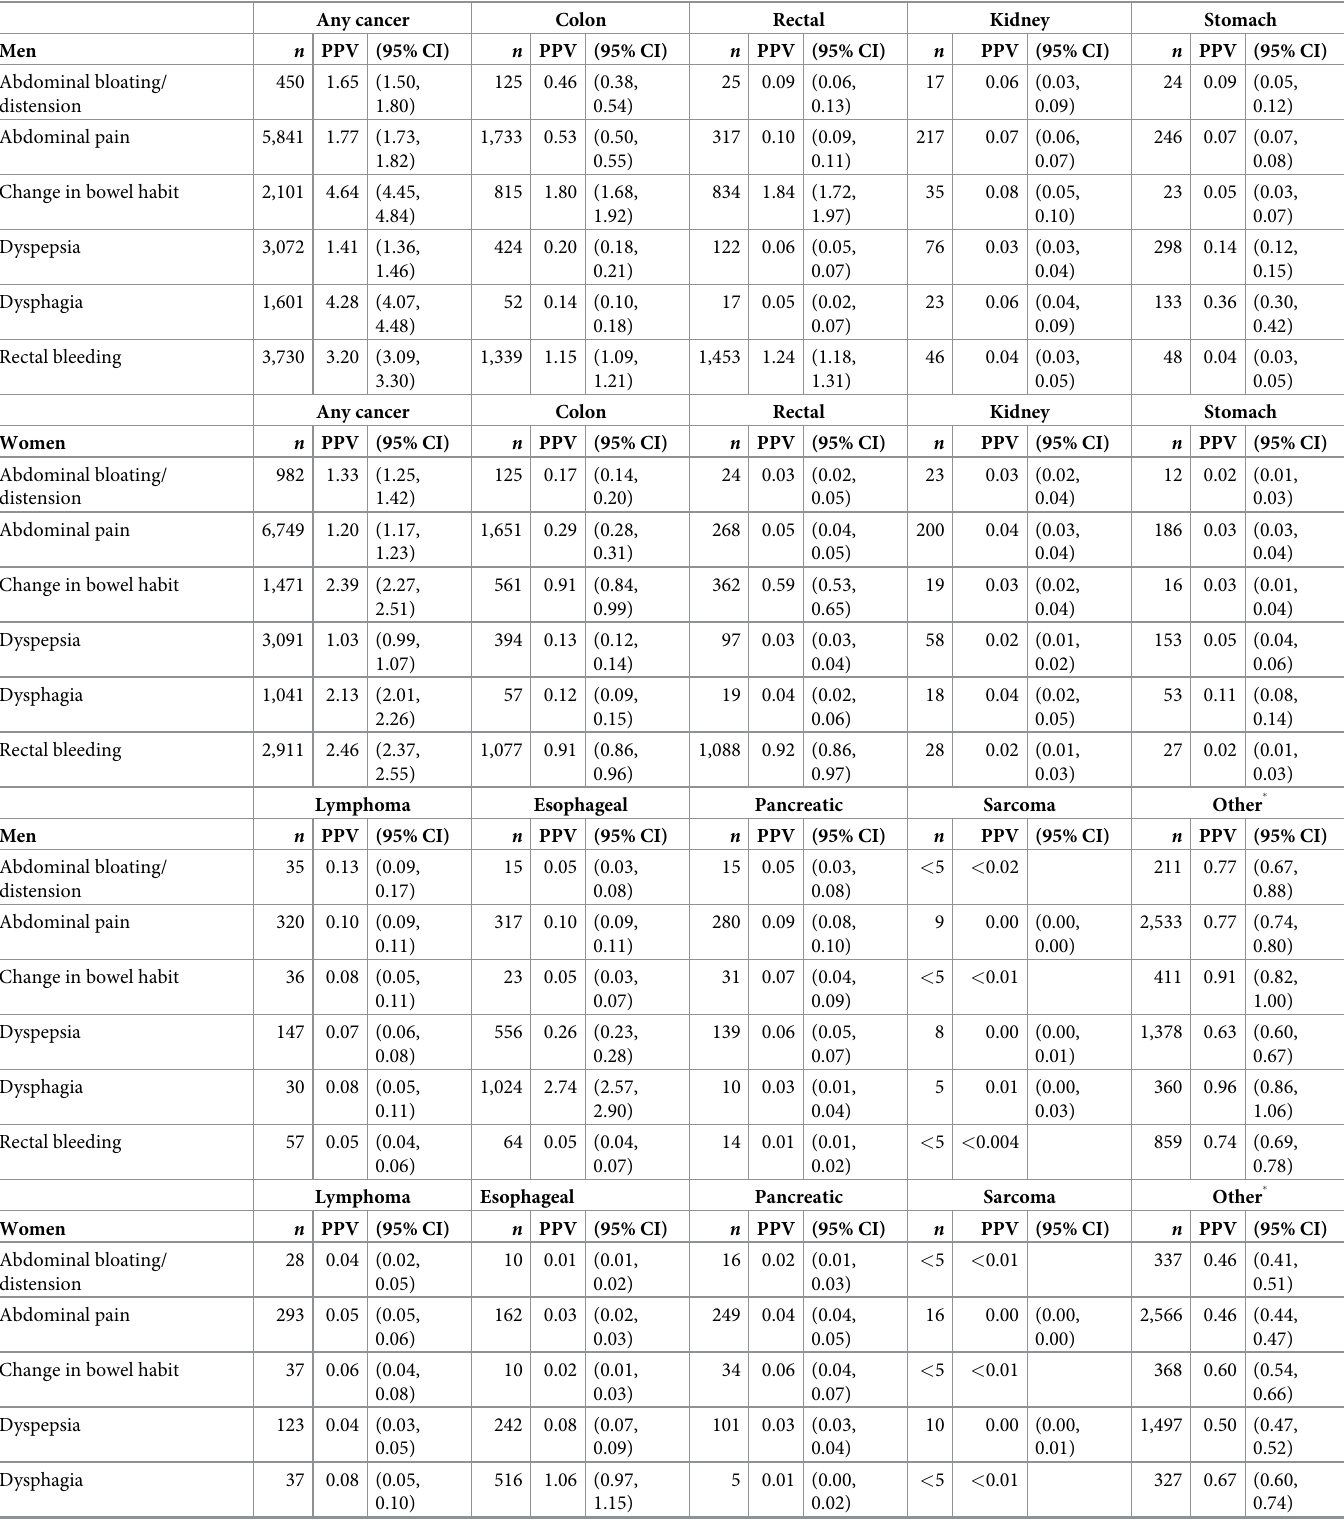
Table 5. Number of incident cases and PPVs (95% CIs) for cancer in the year following a studied symptom, by cancer site. Any